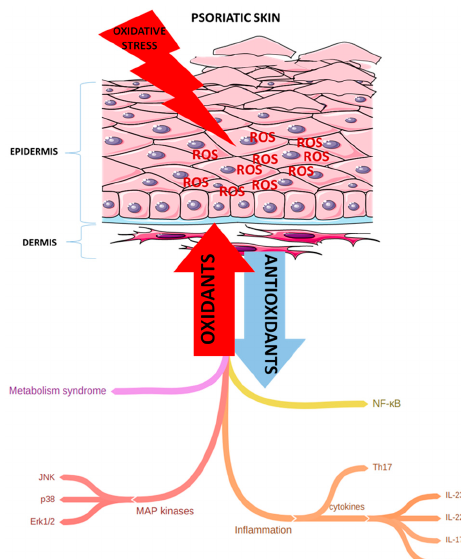
Figure 1. An oxidative stress condition typical for psoriasis. Oxidative stress leads to the overproduction of reactive oxidative species (ROS) that can damage DNA, proteins, lipids, and also results in the activation of many signaling pathways (including nuclear factor kappa-light-chain-enhancer—NF- κ B and MAP kinase—mitogen-activated protein kinase), and in the stimulation of Th1 and Th17 cells and finally in the secretion of pro-inflammatory cytokines. All of this can lead to psoriatic inflammation. (JNK—c-Jun N-terminal kinase; ERK1/2—extracellular signal-regulated kinase 1/2; IFN γ —interferon γ ; IL-23, IL-22, IL-17—interleukins: 23, 22, 17, respectively).